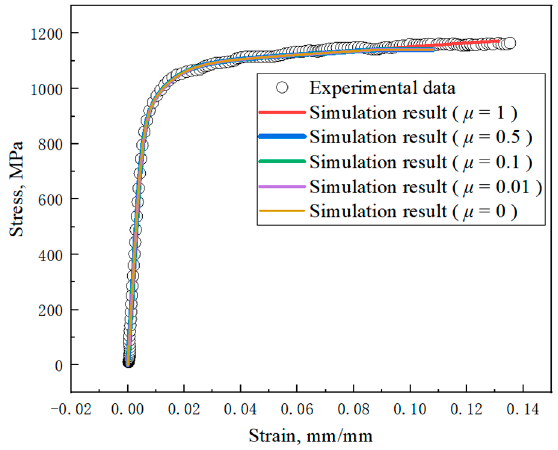
Figure 10. Simulation results of different μ values.